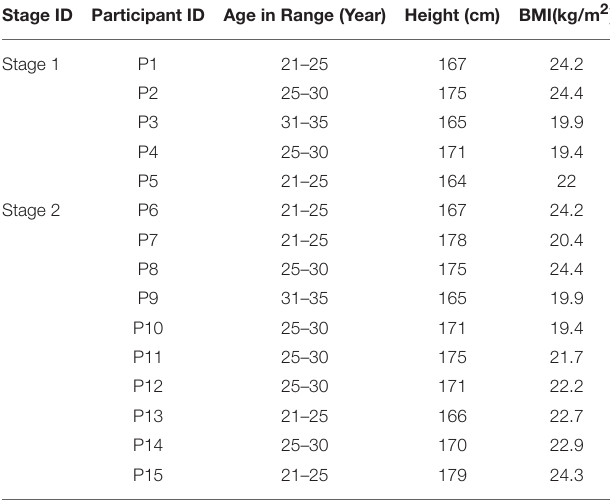
TABLE 1 | Participant characteristics for Stages 1 and